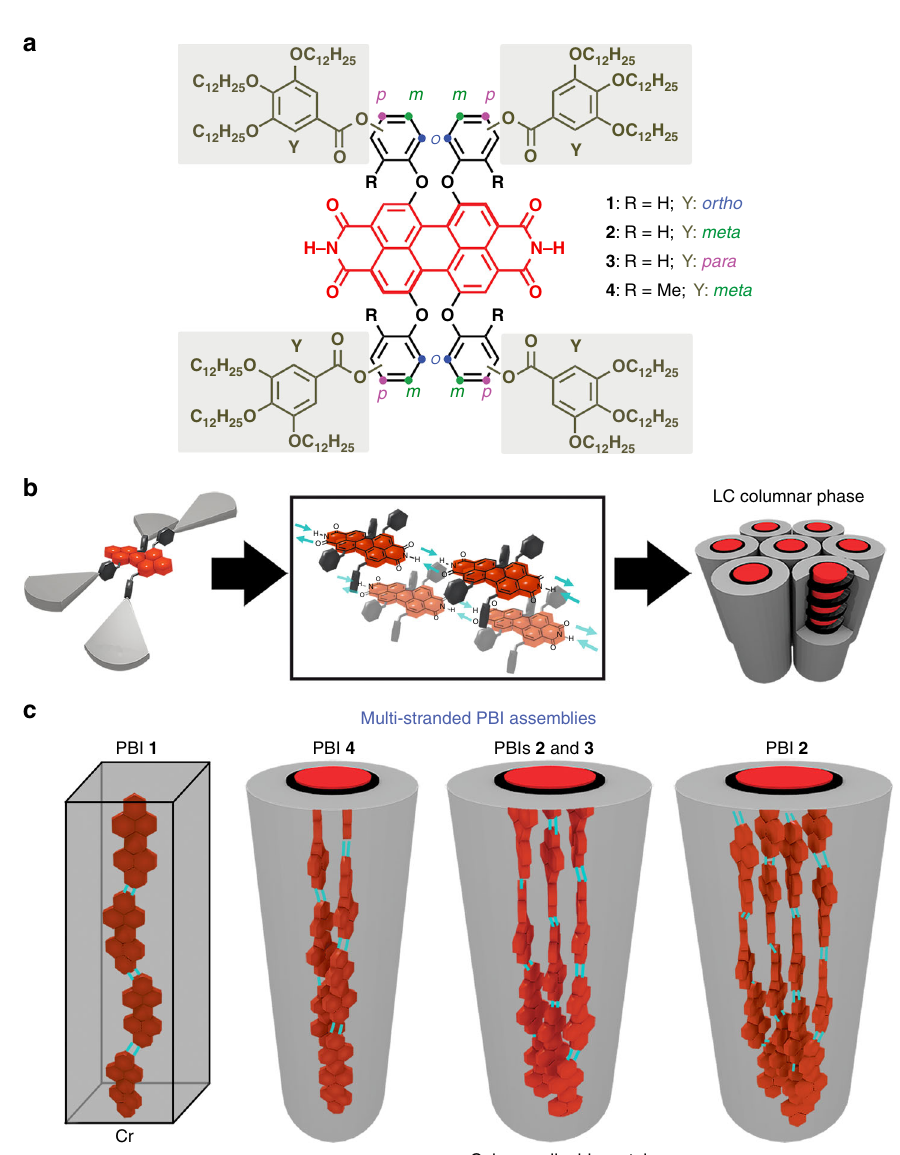
Fig. 1 Molecular design and self-assembled structures of the PBIs 1 – 4 . a Chemical structures of PBIs 1 – 4 . b Schematic illustration of the self-assembly of the PBIs via self-complementary hydrogen bonding (H-bonding) and π – π interactions. c Schematic illustration of the different columnar assemblies composed of one, two, three, and four strands. The helicity in the columnar assemblies of PBIs 2 – 4 has been chosen to be (P) for graphical representation. Please note that PBIs 1 – 4 are racemic and therefore (P) and (M) helices may coexist in the corresponding columnar